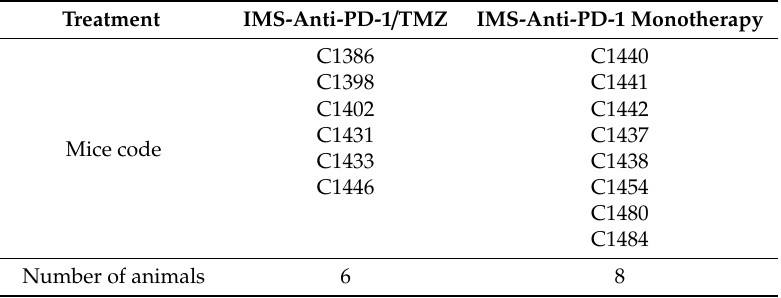
Table 1. Cured mice distribution in di ff erent groups investigated in this